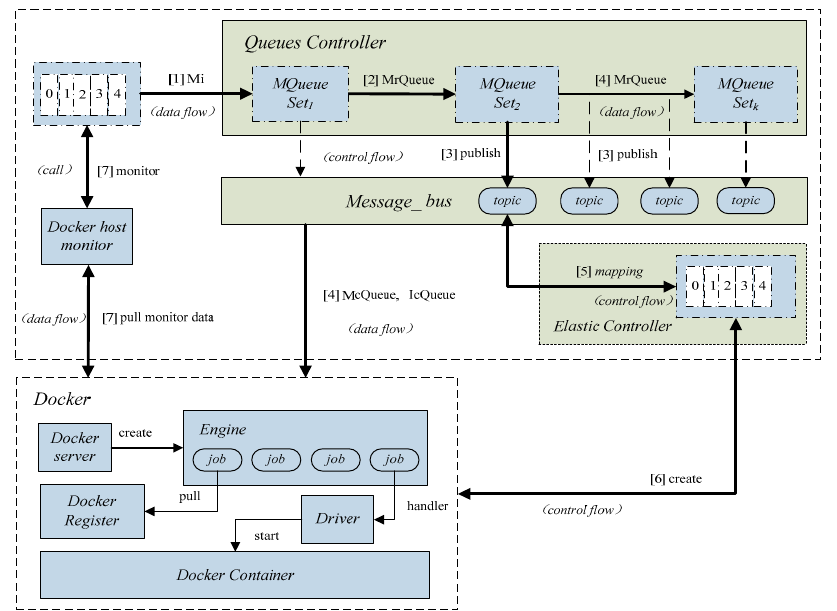
Figure 1. The architecture of Elastic-Docker.